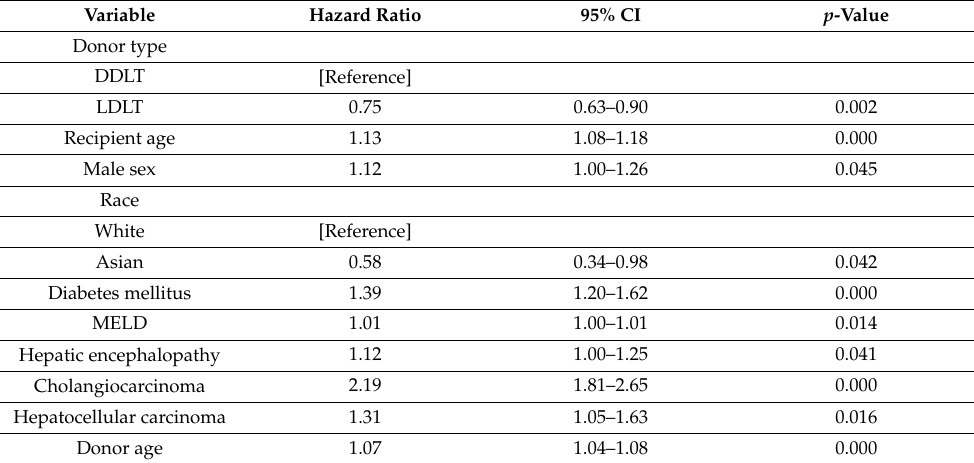
Table 4. Stepwise multivariate Cox proportional hazard analyses of predictors of post-transplant graft